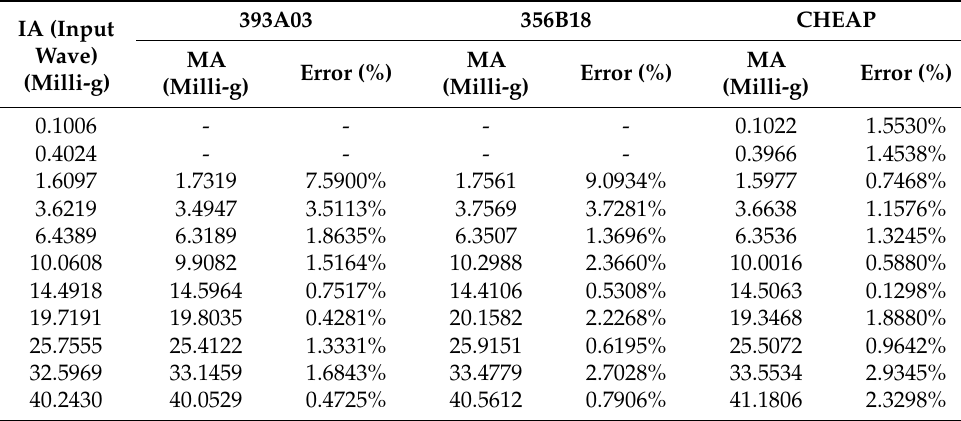
Table 4. Amplitudes extracted from the accelerometers together with their error. IA